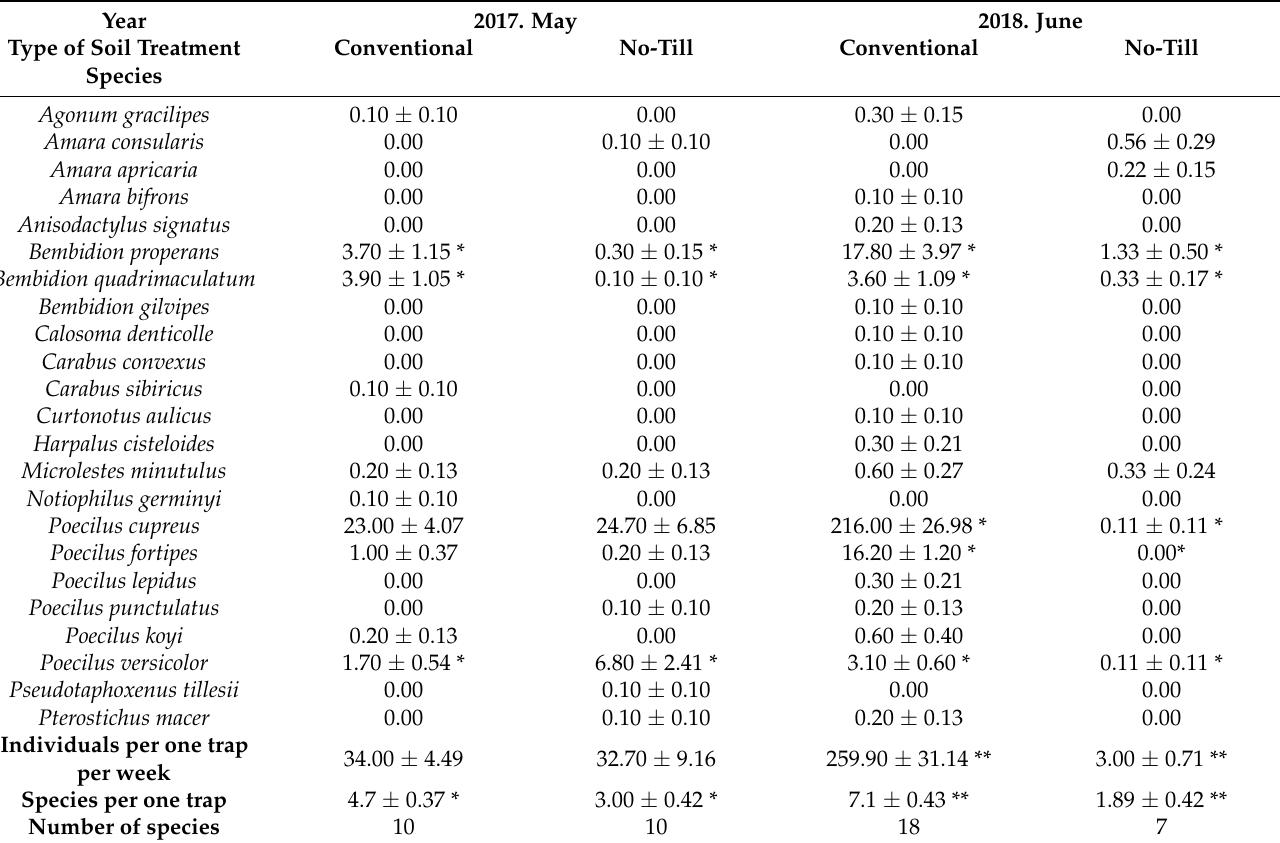
Table 6. Average dynamic density of ground beetles per trap on the conventional and no-till plots in 2017 and 2018. Significant differences are given with asterisks. * p < 0.05, ** p < 0,01. ± : standard